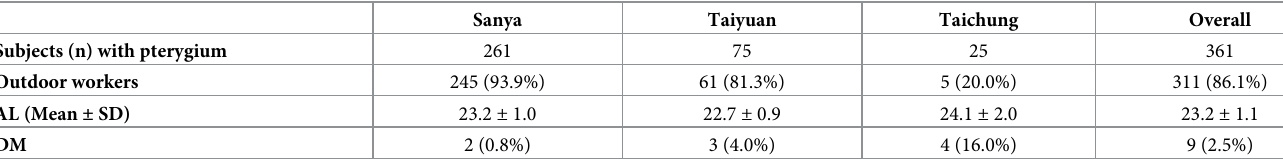
Table 3. Ocular factors associated with